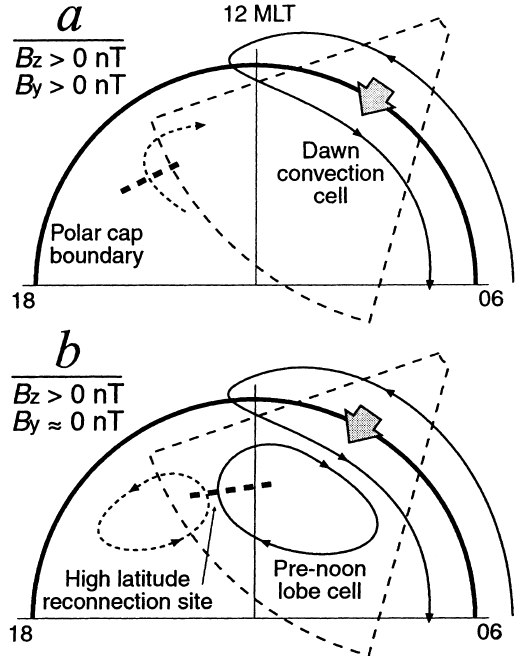
Fig. 6a, b. A schematic diagram of the convection flow pattern observed for IMF B > 0 nT and a B > 0 nT or b B (cid:25) 0 nT. z y y Local noon is toward the top of the figure. The heavy solid line indicates the location of the adiaroic polar cap boundary, and the heavy dashed line indicates the ionospheric footprint of the high- latitude reconnection line. The open arrow shows the motion of the adiaroic boundary. The light arrowed lines represent plasma stream lines. Dotted stream lines show the predicted location of flows not observed by the radar. The radar field-of-view is shown